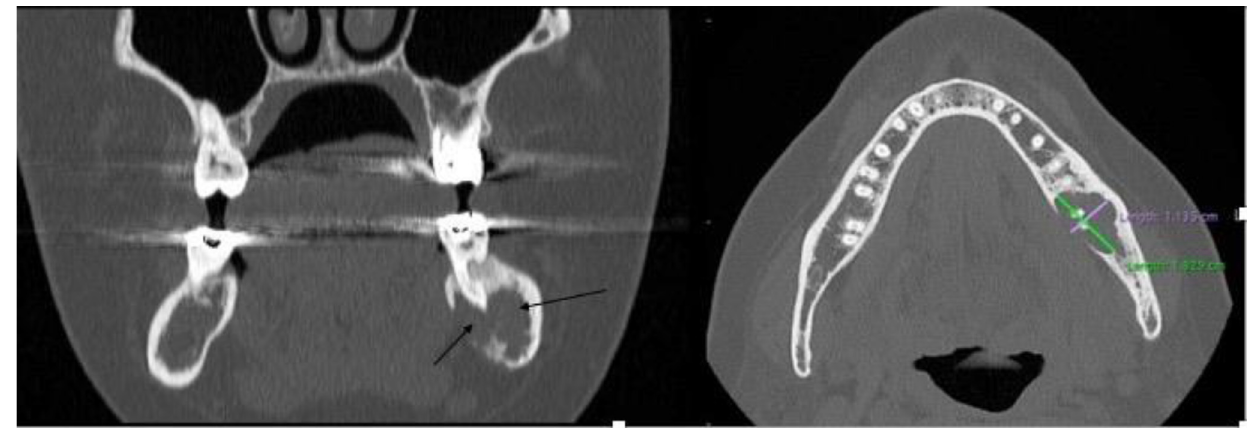
Fig. 2. CT scan: Unique osteolytic lesion of 19 by 11mm of the left mandible around the fi rst and second molar with ill-de fi ned margins and a mandibular canal